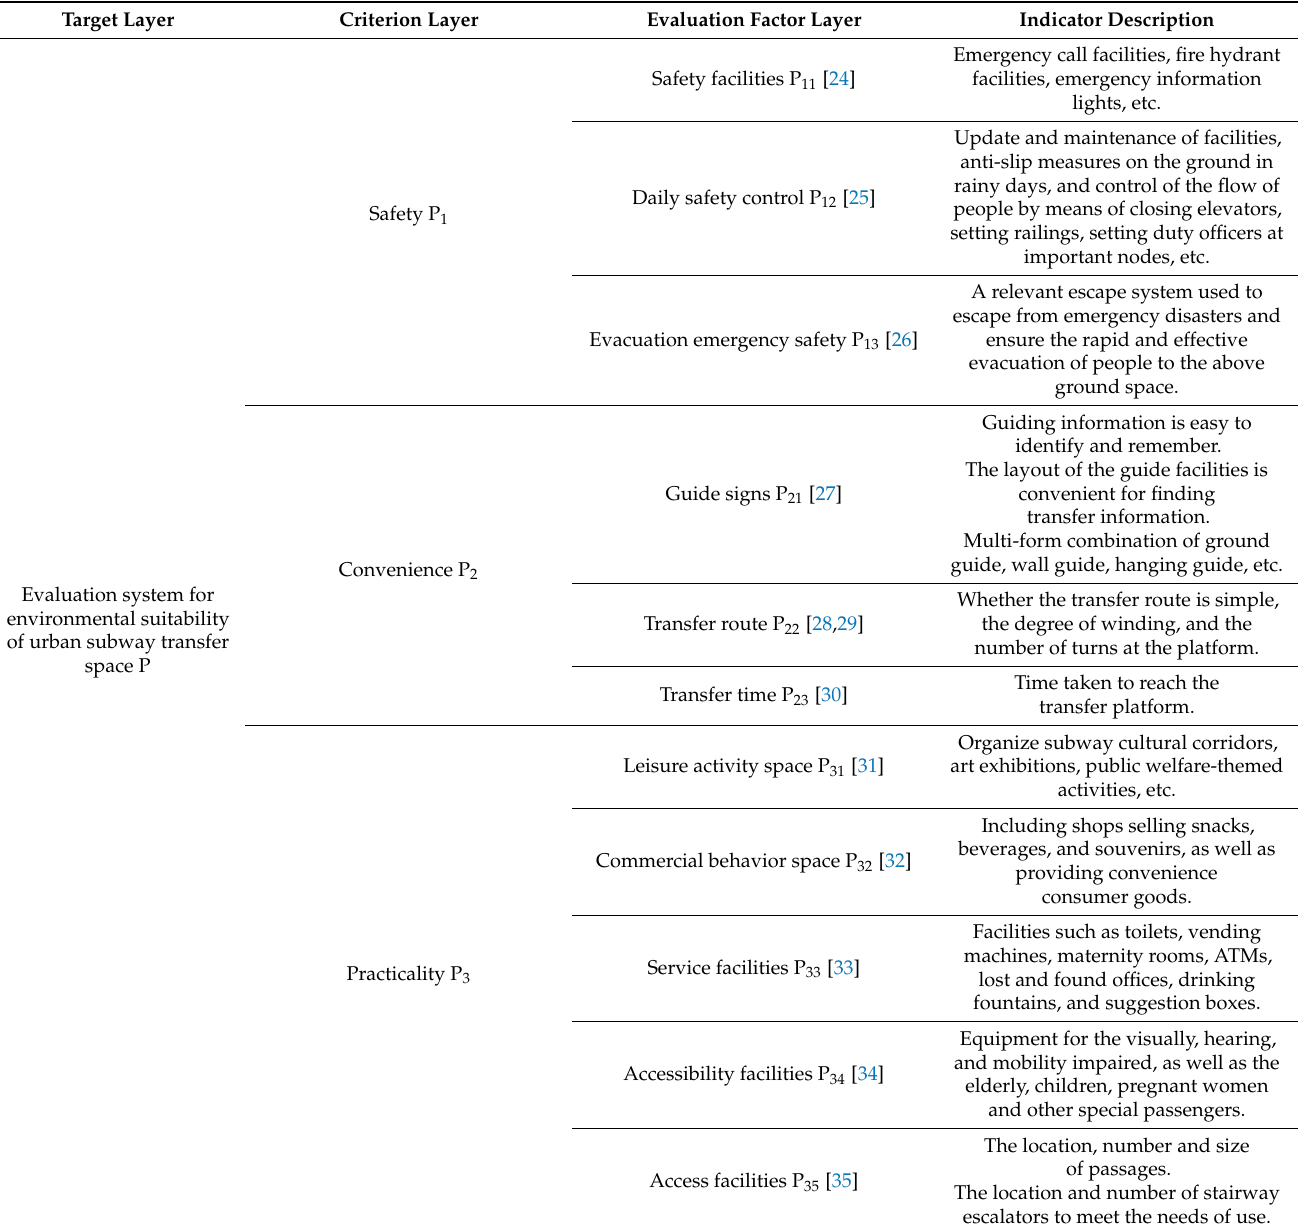
Table 2. Evaluation indicators and descriptions of the environmental suitability of transfer spaces in urban subway